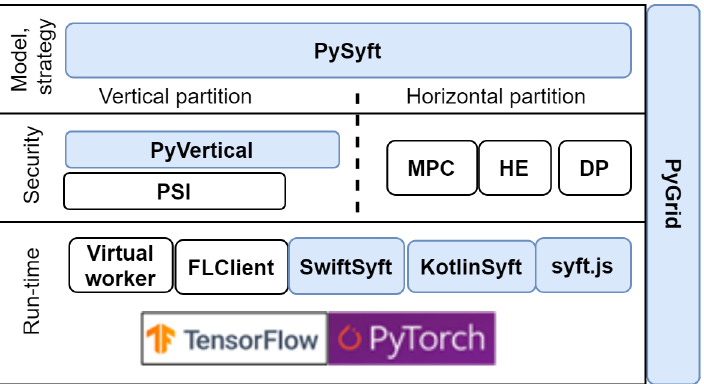
Figure 7. Architecture of